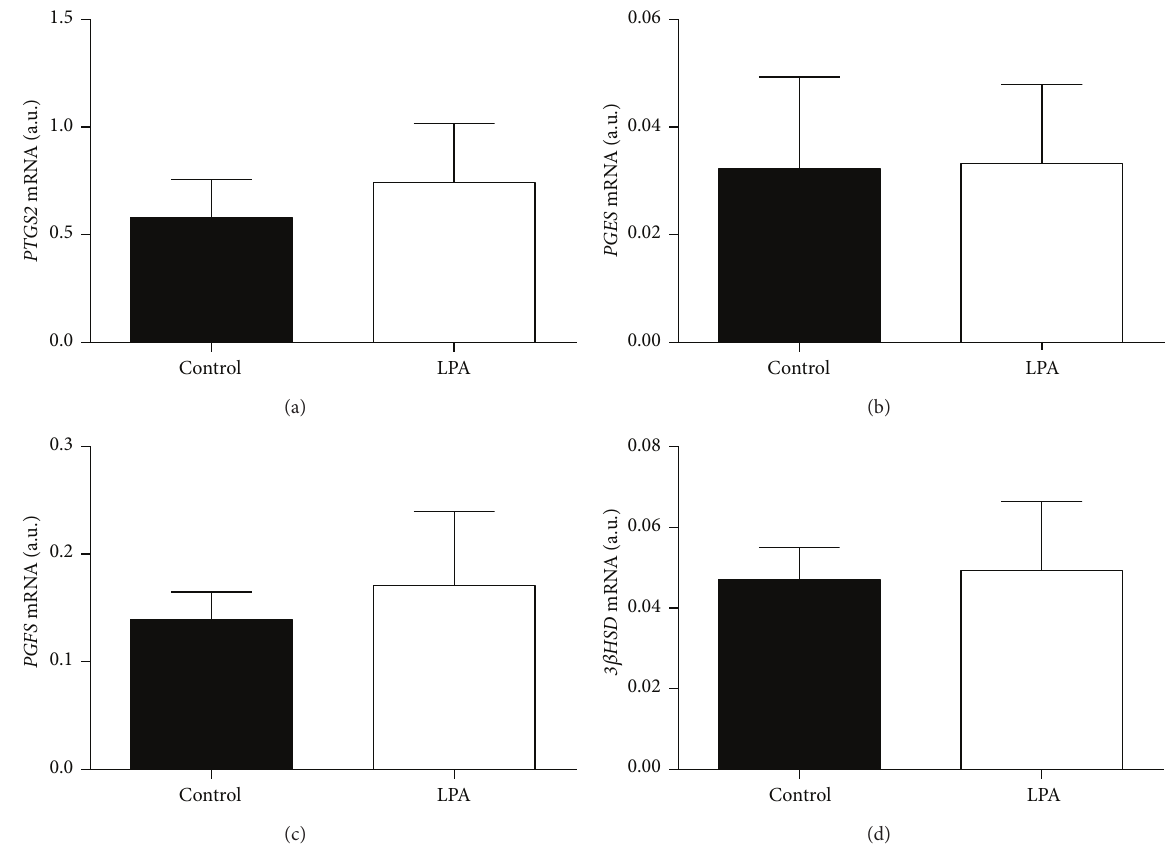
Figure 6: Effect of LPA stimulation on transcription levels of genes coding for PG ((a) PTGS2 ; (b) PGES ; (c) PGFS ) and P 4 ((d) 3 𝛽 -HSD ) synthesis enzymes in bovine in vitro produced